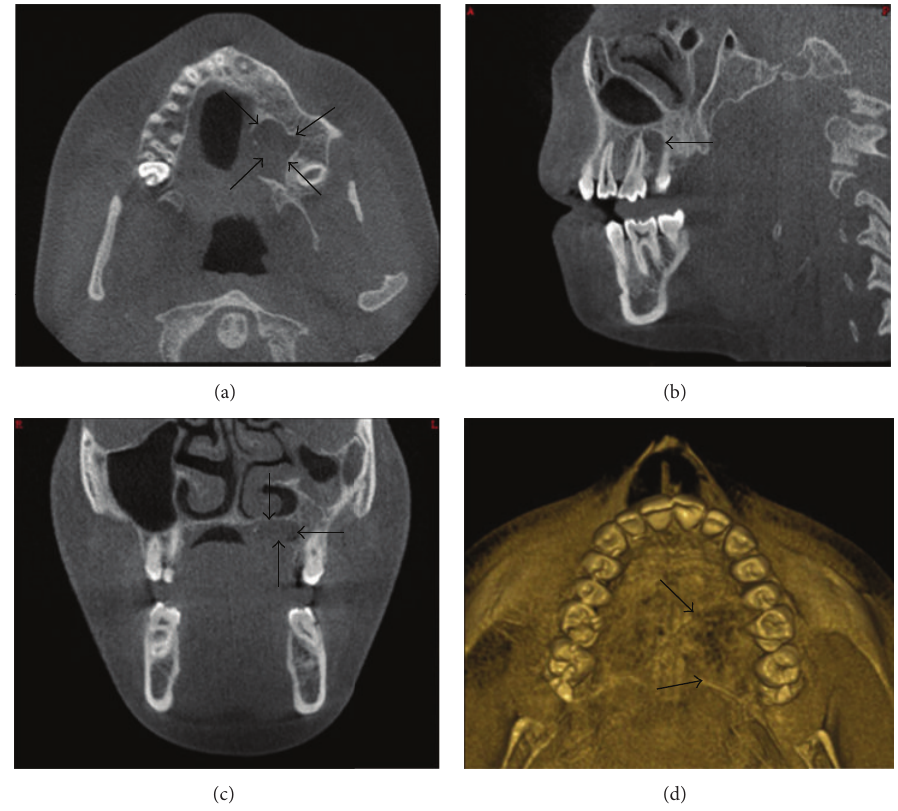
Figure 2: Dental volumetric tomography images of MEC (black arrows); (a) axial, (b) sagittal, (c) coronal, and (d) 3D